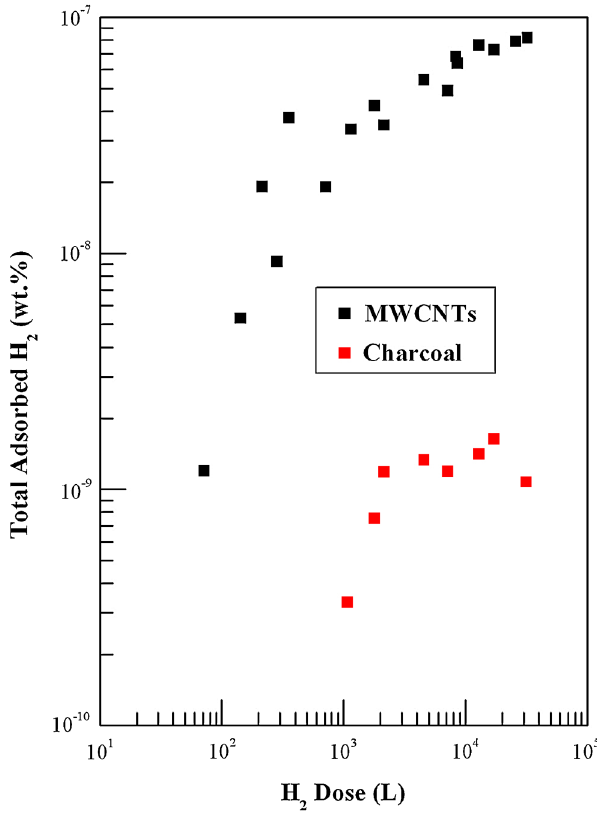
FIG. 3. (Color) Molecular hydrogen adsorbed on MWCNTs as a dose for adsorption temperature of T function of H 2 ¼ 15 K and P ¼ Also shown are the results for a charcoal sample. The active ad ad surfaces are 174 m 2 = g and 23 m 2 = g for MWCNTs and charcoal,